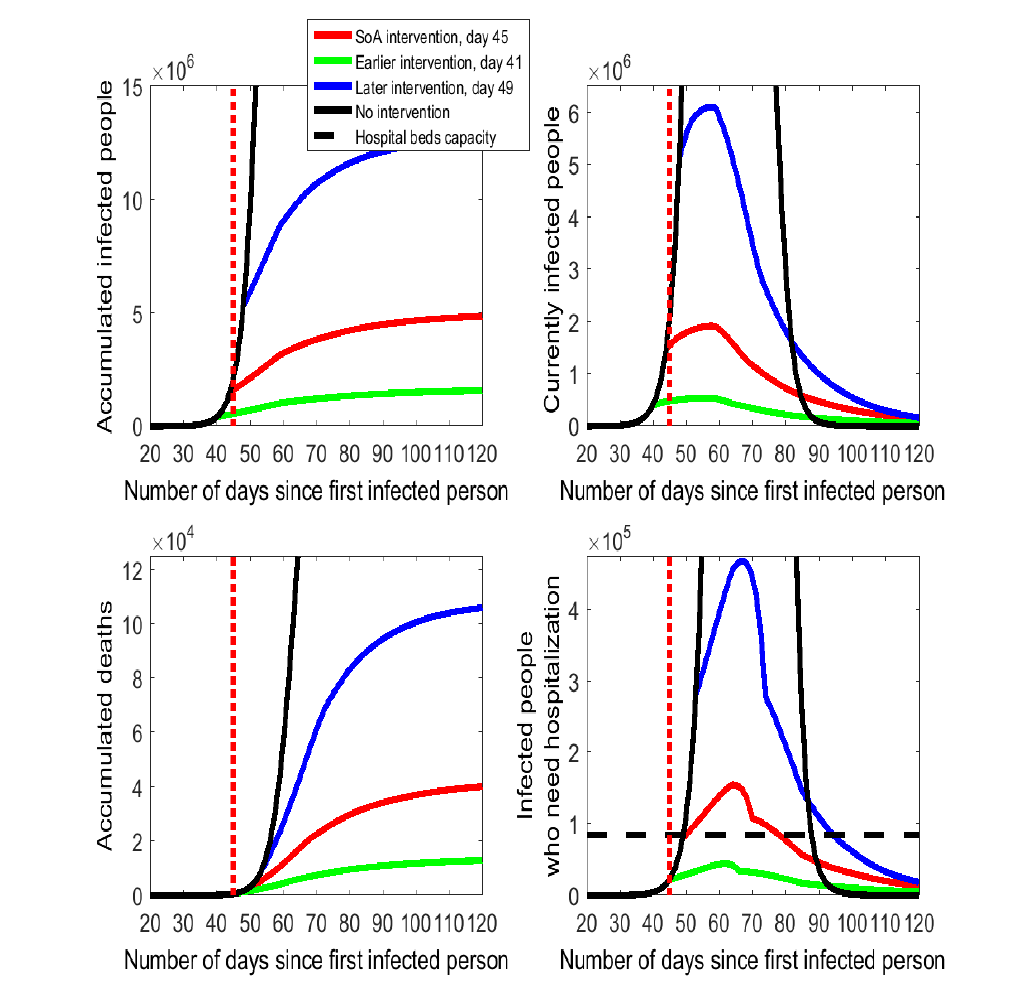
Figure 2. Alternative timings for the isolation policy in Spain following the COVID-19